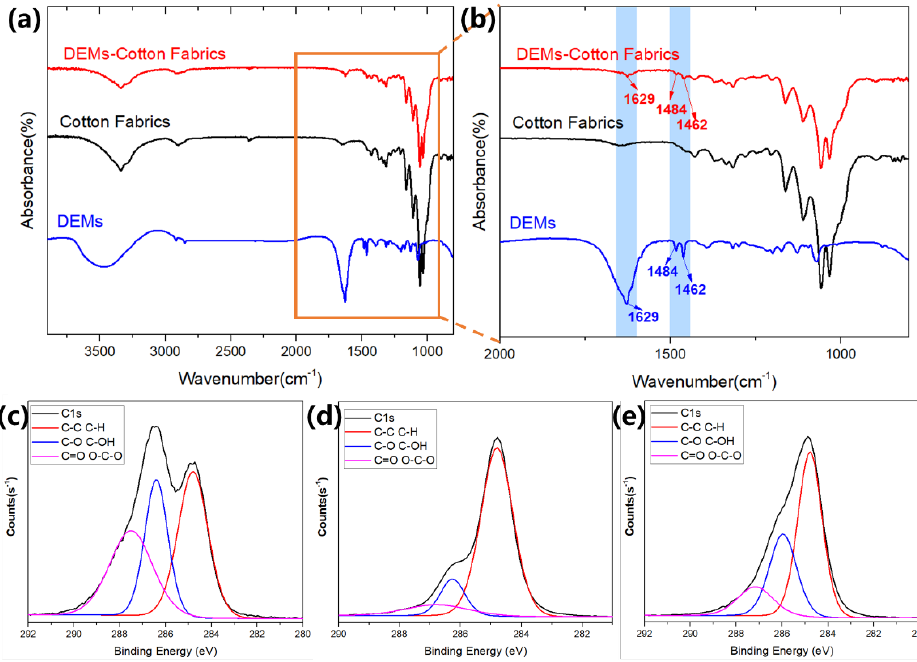
Figure 3. ( a ) IR spectra and ( b ) enlarged partial IR spectra of DEMs-cotton fabrics, cotton fabrics and DEMs. High-resolution X-ray Photoelectron Spectroscopy (XPS) spectra for C1s peaks of ( c ) cotton fabrics ( d ) DEMs, and ( e ) DEMs-cotton fabrics.